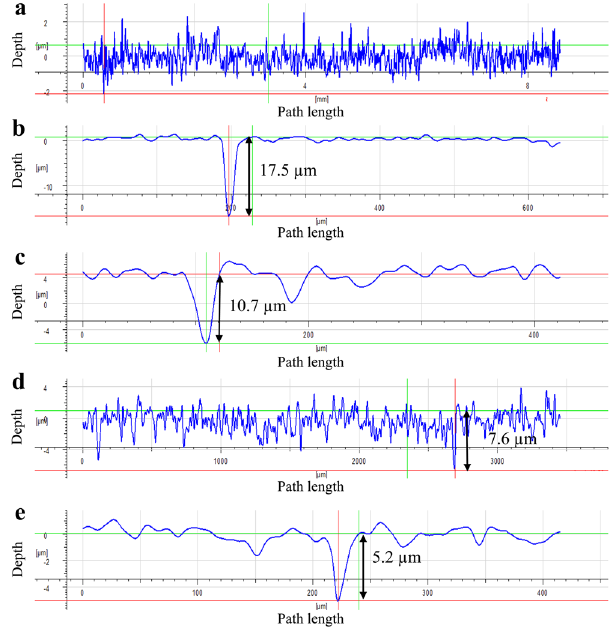
Figure 5. IFM pit depth profile of coupons after the 7-day biofilm prevention test with: ( a ) abiotic control, ( b ) no treatment, ( c ) 2 ppm D-tyr, ( d ) 30 ppm CIP, and ( e ) 30 ppm CIP + 2 ppm D-tyr. (Scale bars in the small inserted images are 50 μ m).